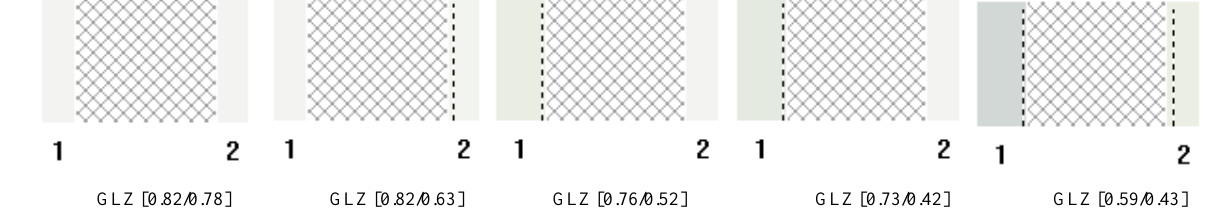
Fig. 1 Glazing coated surfaces; 1- Outer glass pane 2- Inner glass pane Dotted line: position of